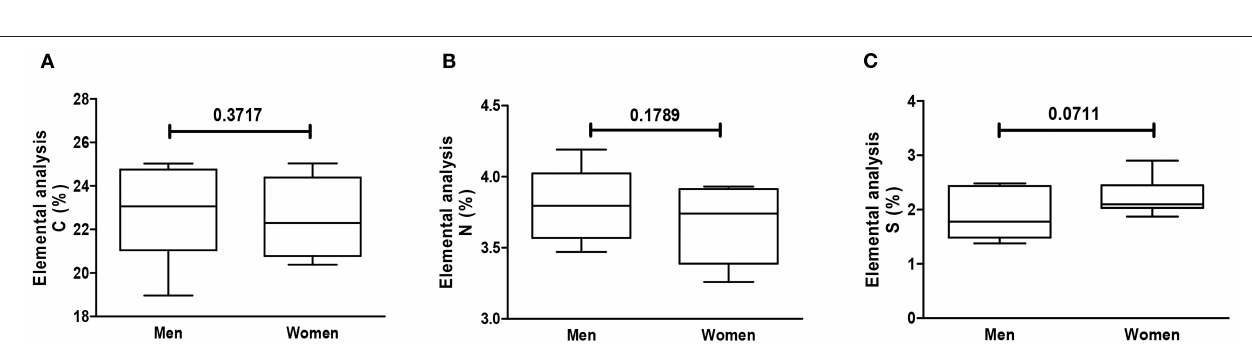
FIGURE 3 | Elemental analysis of GAG per gender. Elemental analysis of GAG from human cartilage samples of patients subjected to arthroplasty secondary to OA or fracture patients. Data represent medians (IQR) of relative percentage of carbon (C), nitrogen (N), hydrogen (H), and sulfate (S) of at least n = 6/group; Kruskal–Wallis